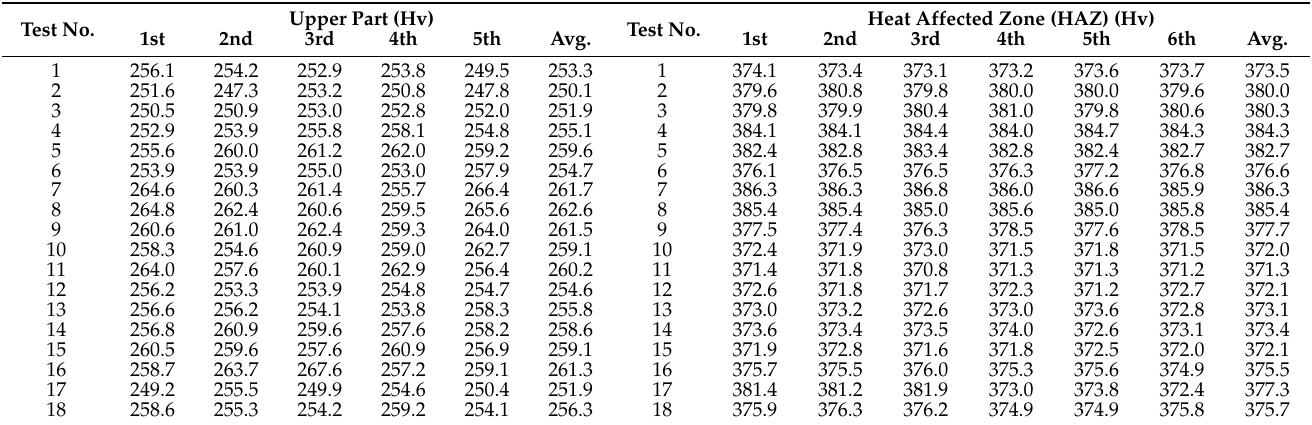
Table 6. Hardness test results.